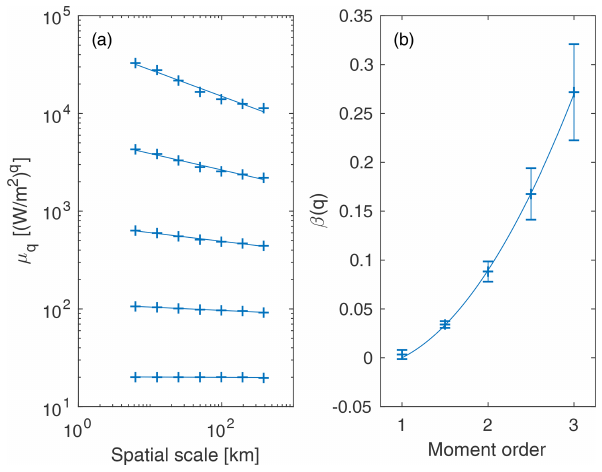
Figure 5. (a) The spatial scaling of simulated heat fluxes in the Central Arctic region over JFM 2007. The lines are linear least- squares fits for each moment (order 1, 1.5, 2, 2.5, and 3 from bottom to top). (b) The resulting structure function and a quadratic fit. The error bars are the uncertainty in the least-squares fit for the moments in (a)